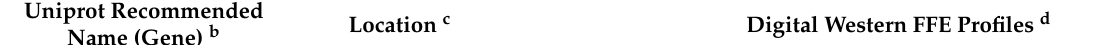
Table 5. Digital western FFE profiles of mitochondrial markers a .